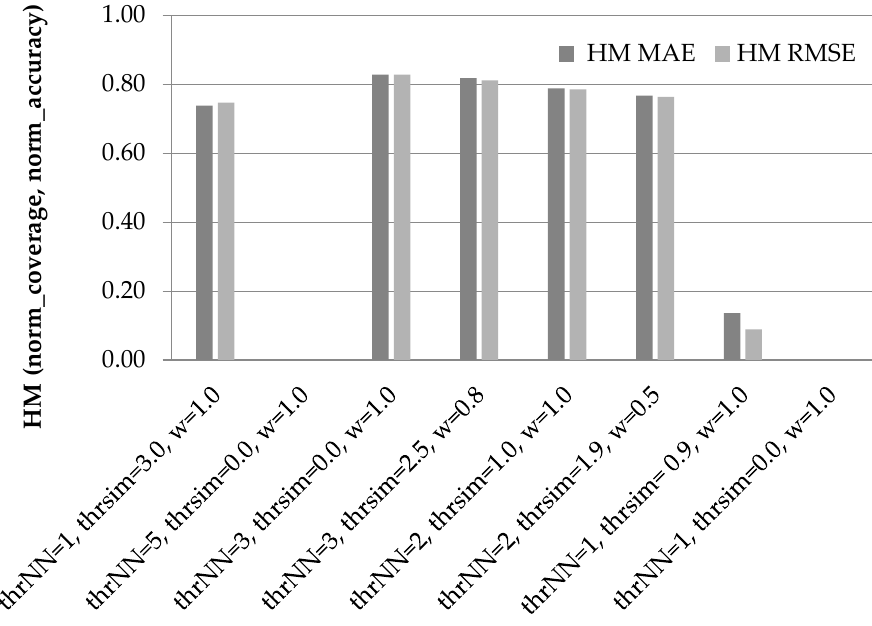
Figure 4. Harmonic Mean of the normalized accuracy and coverage increase measures for the candidate setting, when using the CS as the similarity metric.